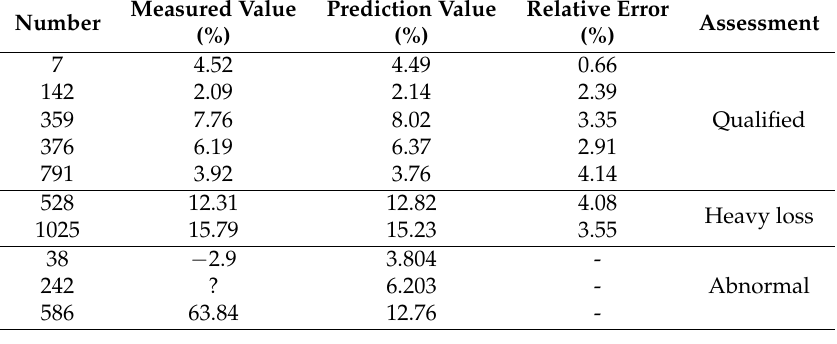
Table 4. Assessment of the LV distribution network.